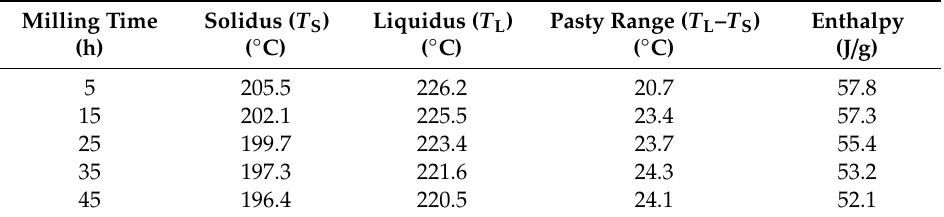
Table 4. Thermal characteristics of Sn-0.7 alloy as a function of milling time.